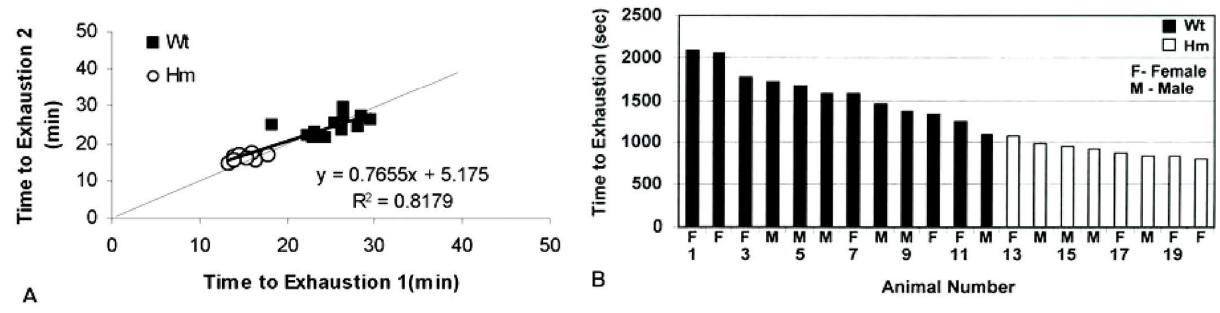
Figure 2. Exercise Capacity of wild type and mutant rats. Rats were exercised to exhaustion on a treadmill (see Materials and Methods). The running protocol was repeated twice. A. Reproducibility of measured maximal exercise capacity. The correlation of the 2 measurements was demonstrated by the large R 2 value, near unity of slope, and small intercept; B. Wild type and homozygote mutant rats had significantly different maximal exercise capacity, defined as time to exhaustion. The maximal exercise capacity averaged 9.3 minutes longer in wild type rats than in mutants. P-value <0.001 was based on a T-test. Wt; wild type; Hm; Homozygous mutant; F; female; M; Male.